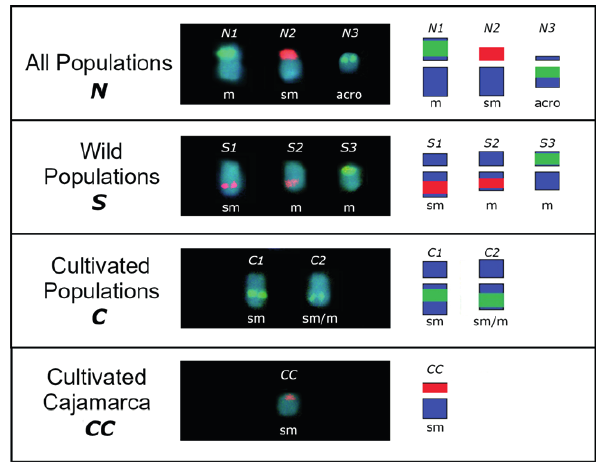
Figure 5 Characterization of the nine types of chromosomes that showed rDNA probe hybridization based on their existence in populations, morphology, size, presence of the 5s or 45s locus, posi- tion of the rDNA locus, and rDNA probe fluorescence intensity, m=metacentric, sm=submetacentric, and acro=acrocentric.